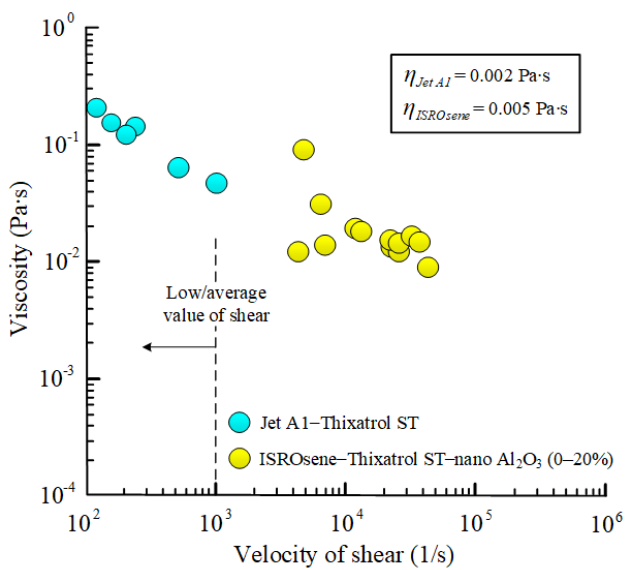
Figure 3. Viscosity change with shear rate under conditions of xylene gel (Jet A1 jet fuel, Thixatrol ST organic thickener) [113] and gel propellant with Al 2 O 3 particles (ISROsene kerosene, Thixatrol ST organic thickener, xylene) [69,70] to spray device and during atomization.